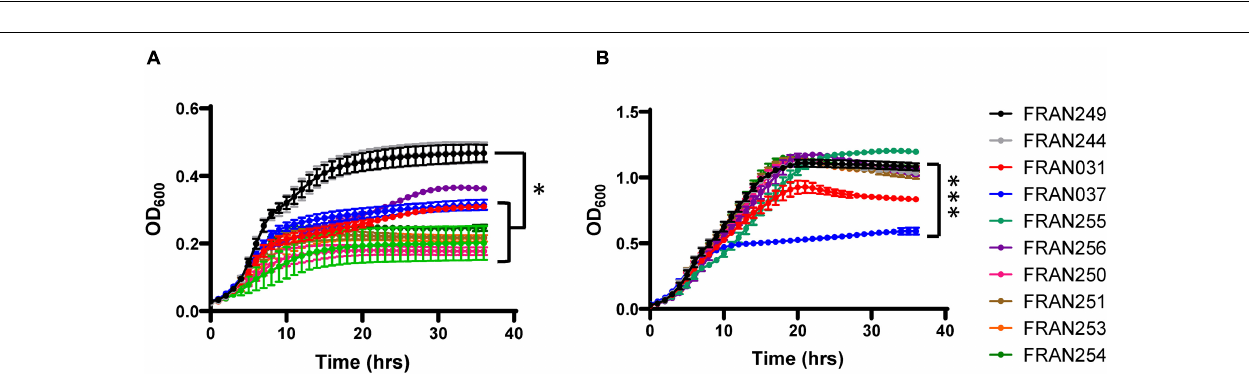
FIGURE 4 | Map of mutations identified in the Francisella pathogenicity islands. The regions spanning pdpA - anmK from FPI-1 (top) and FPI-2 (bottom) of the Schu S4 strain are shown to scale (FTT_1344.FTT_1361c; FTT_1699.FTT_1717). Markers indicate approximate locations of mutations identified in the FPI genes, colored according to the F. tularensis strains in which they were observed; FRAN249 - black, FRAN244 - gray, FRAN037 - blue, FRAN256 - purple, FRAN251 - brown.